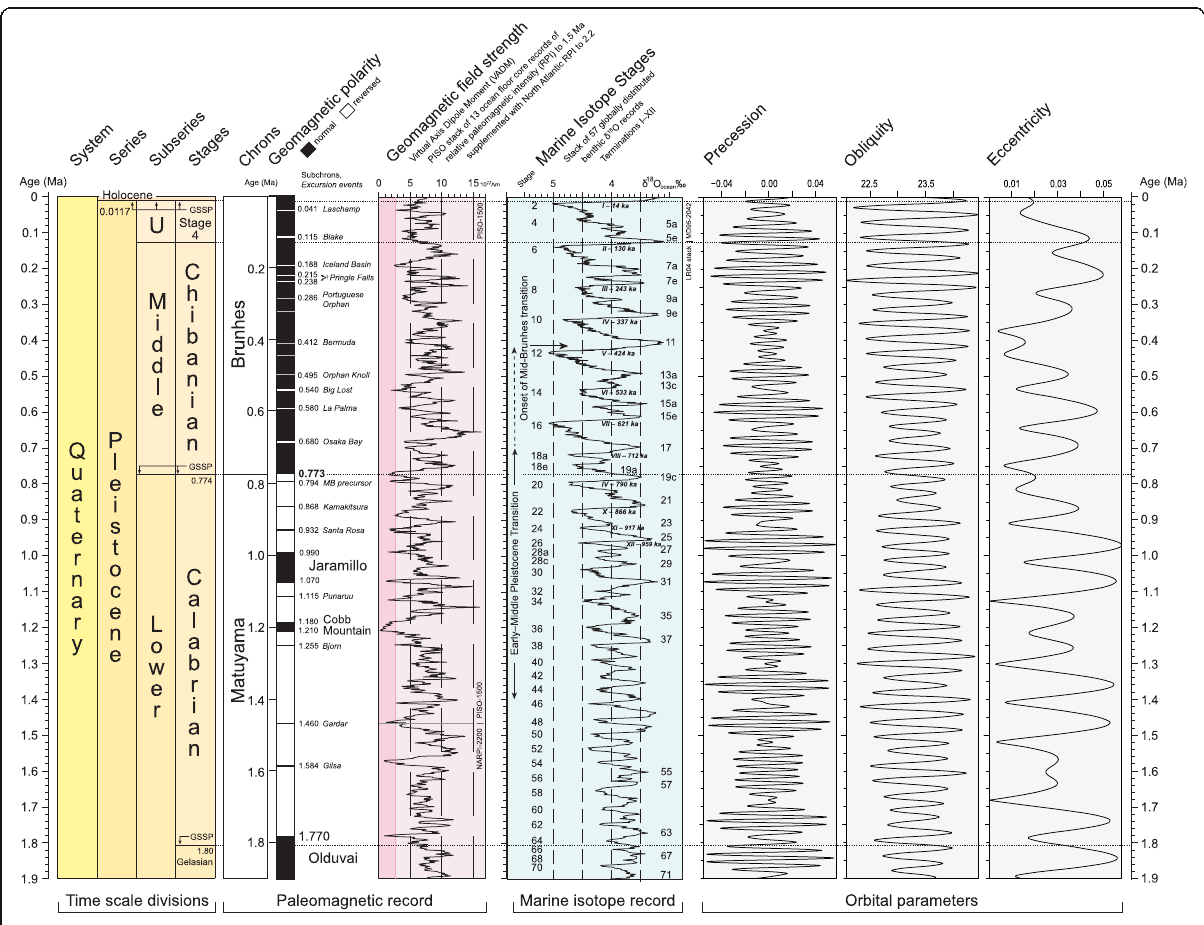
Fig. 2 Stratigraphic correlation table and orbital parameters for the last 1.9 million years, including the Early – Middle Pleistocene transition (1.4 – 0.7 Ma, Sánchez-Goñi et al. 2019; or 1.4 – 0.4 Ma, Head and Gibbard 2015b). The time scale is based on Fig. 1; geomagnetic polarity reversals and field paleointensity data are from Cohen and Gibbard (2019) and Channell et al. (2016, 2020) with ages of reversals based on orbital tuning of the sedimentary record (Channell et al. 2020); marine isotope record and numbering of marine isotope stages is from Lisiecki and Raymo (2005), with ages of terminations from Lisiecki (undated) and selected substages from Railsback et al. (2015); orbital parameters representing precession (Laskar et al. 2004), obliquity (Laskar et al. 2004), and eccentricity (Laskar et al. 2011) are from Head and Gibbard (2015b). Updated from Cohen and Gibbard